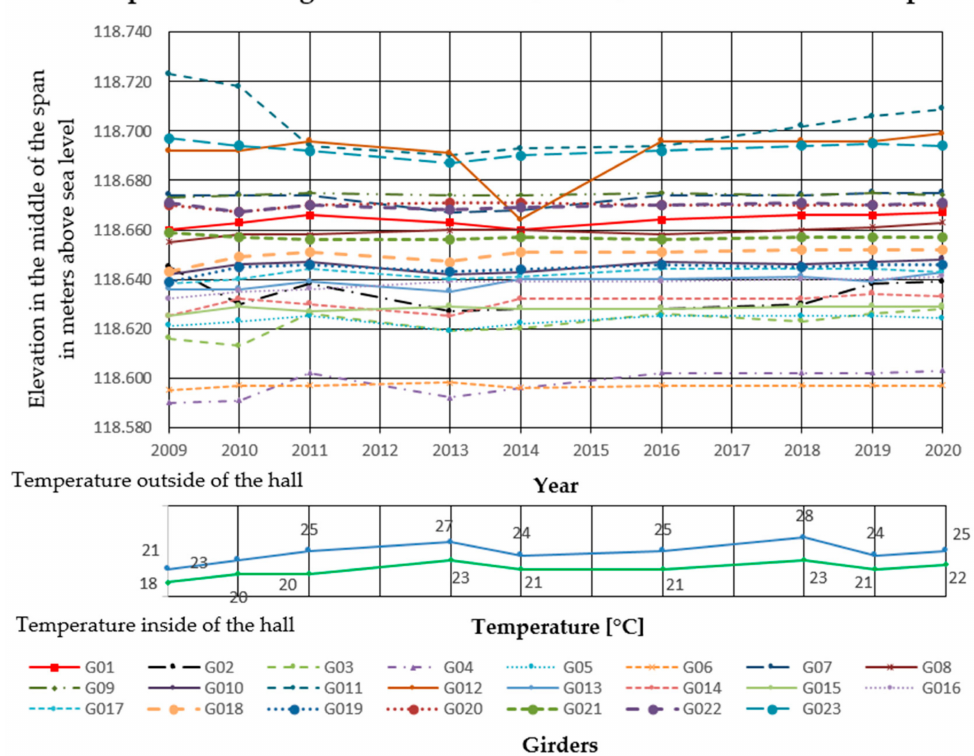
Figure 9. Displacement of the girders in the middle of the span in Hall B.